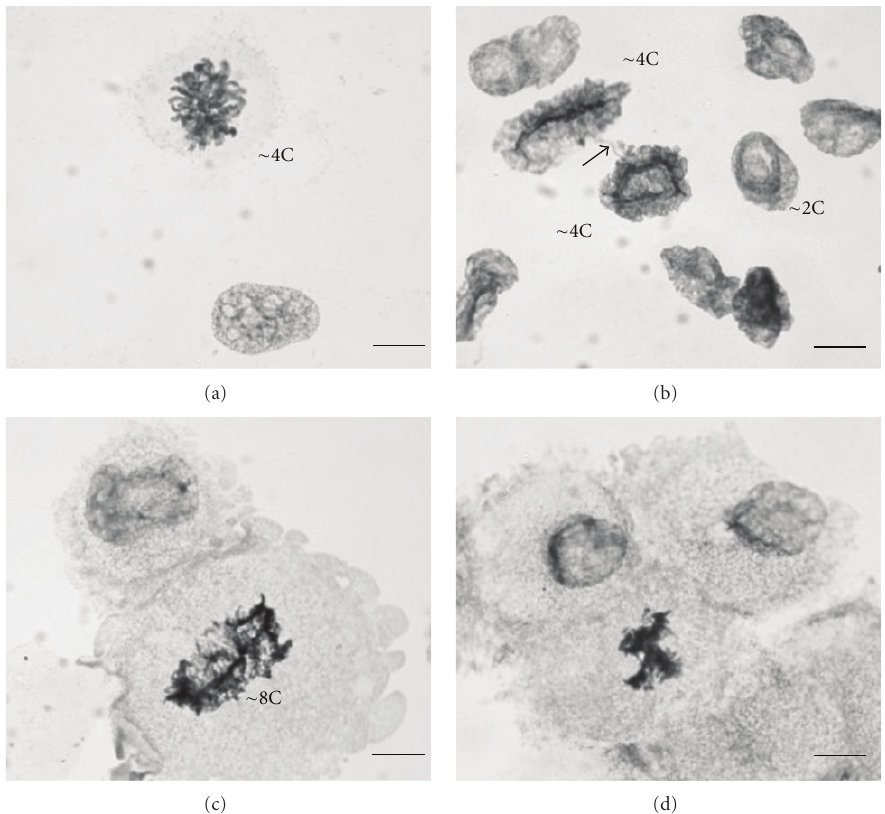
Figure 8: Mitoses of IMR90: (a) normal mitosis of a diploid cell in the growth stage, ((b)–(d)) mitoses in the presenescence stage. (b) Anaphase of the tetraploid cell, chromosome bridge (arrowhead) indicates to CIN. (c) Metaphase of the large tetraploid cell ( ∼ 8C). (d) An attempt of the tetrapolar mitosis indicating to CIN. ((a),(b)) stoichiometric staining for DNA with Toluidine blue pH 4.0 after extraction of RNA. ((c),(d)) Similar staining after partial extraction of RNA. Scale bar = 10 μ